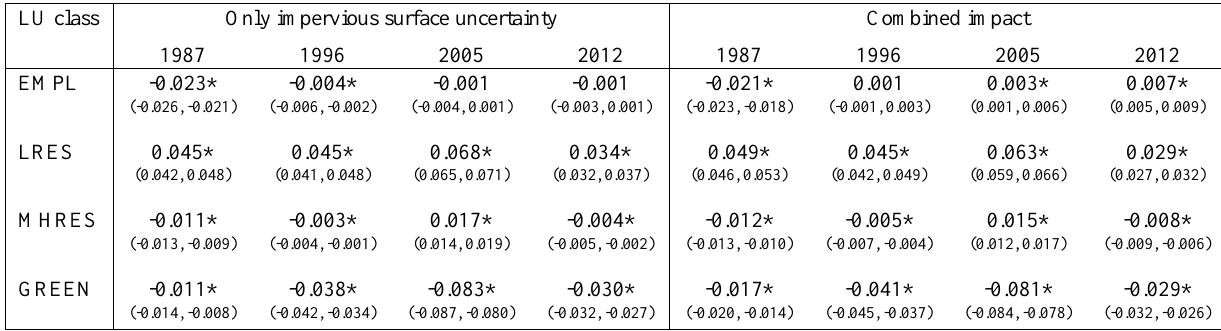
Table 1. Difference in proportions relative to the original classification for all land-use classes for the approach only accounting for impervious surface errors (left part) and for the approach combing both sources of error (right part). The 95% confidence intervals are defined between brackets; differences significant at the 0.05 level of significance are indicated with a